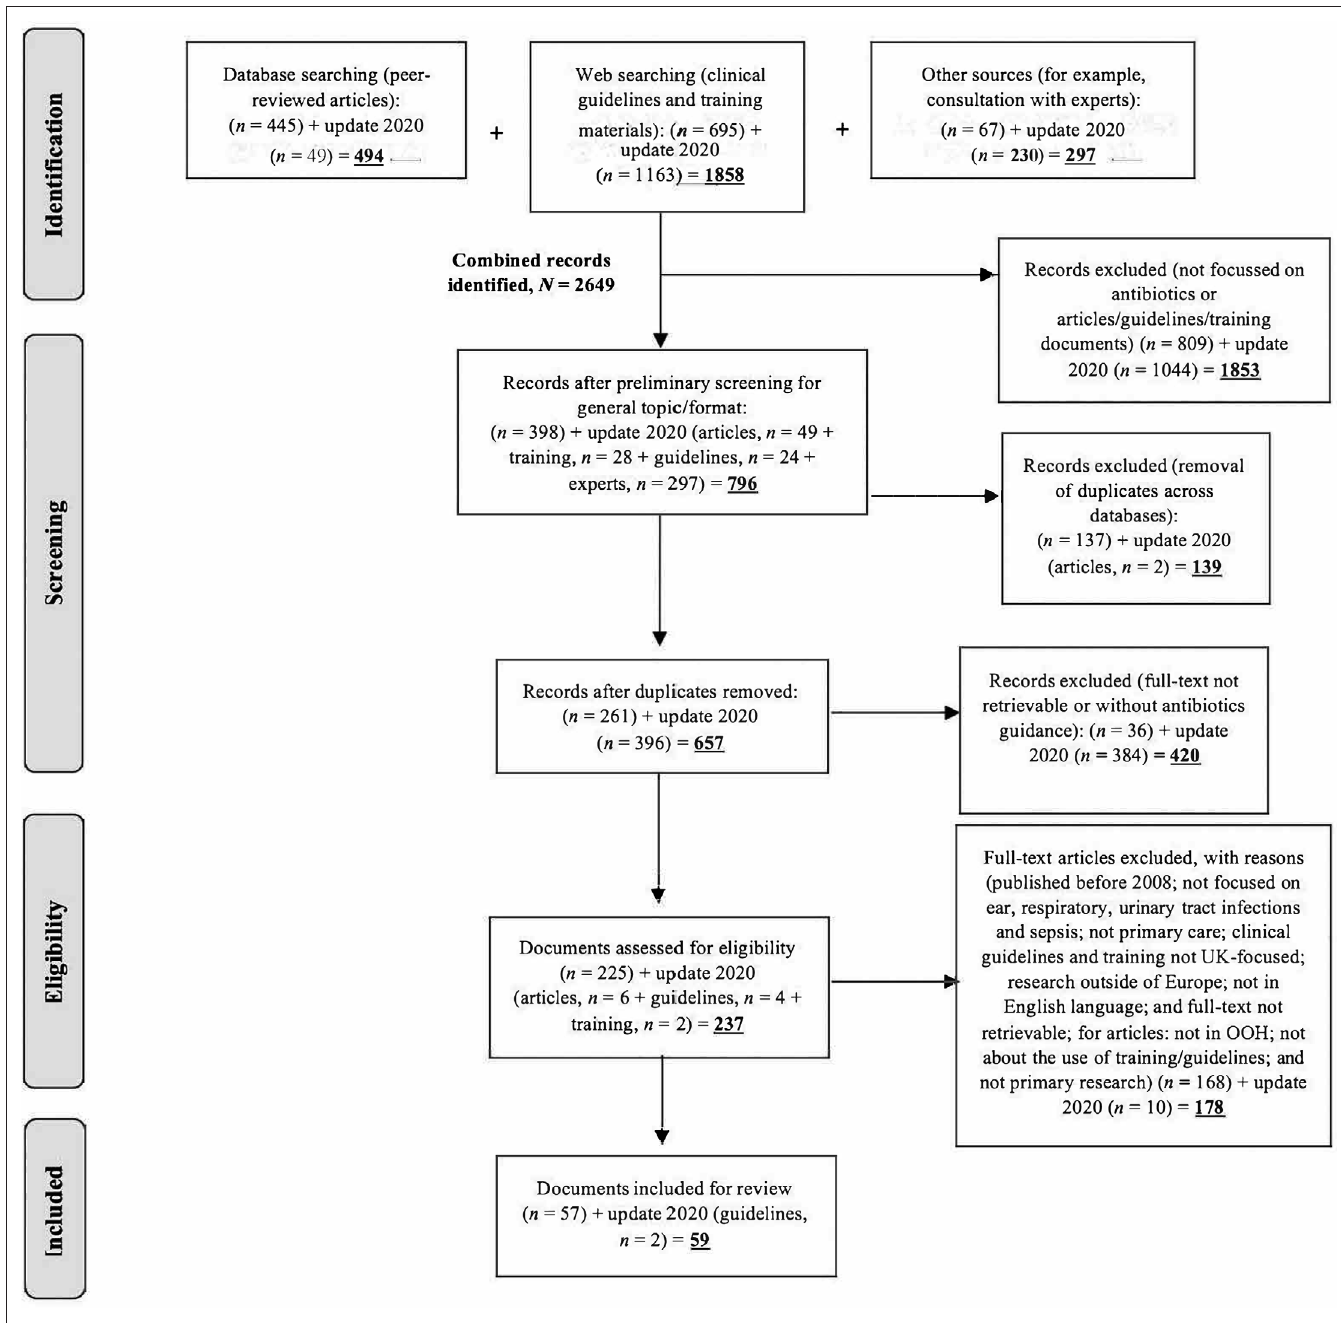
Figure 1 Selection flowchart and reasons for